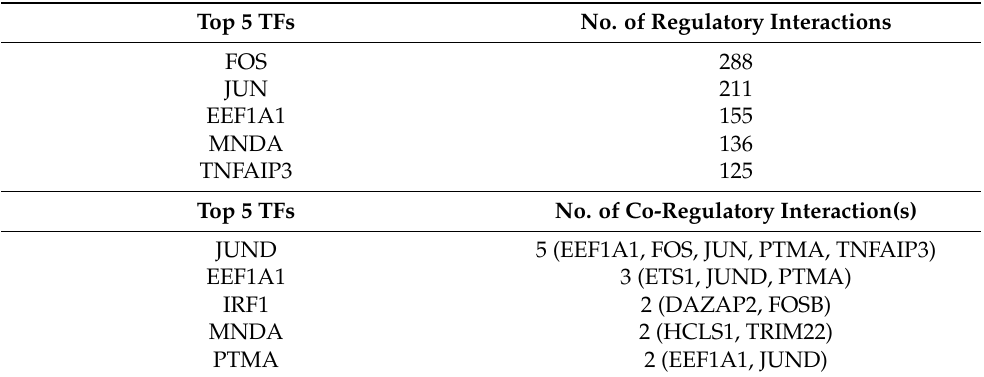
Table 1. Top 5 of the CoRegNet identified transcription factors (TFs) with the highest number of regulatory interactions (TF–target gene) and co-regulatory interactions (TF–TF). The analysis was performed using data from 90 samples, 48 Controls, and 42 RA